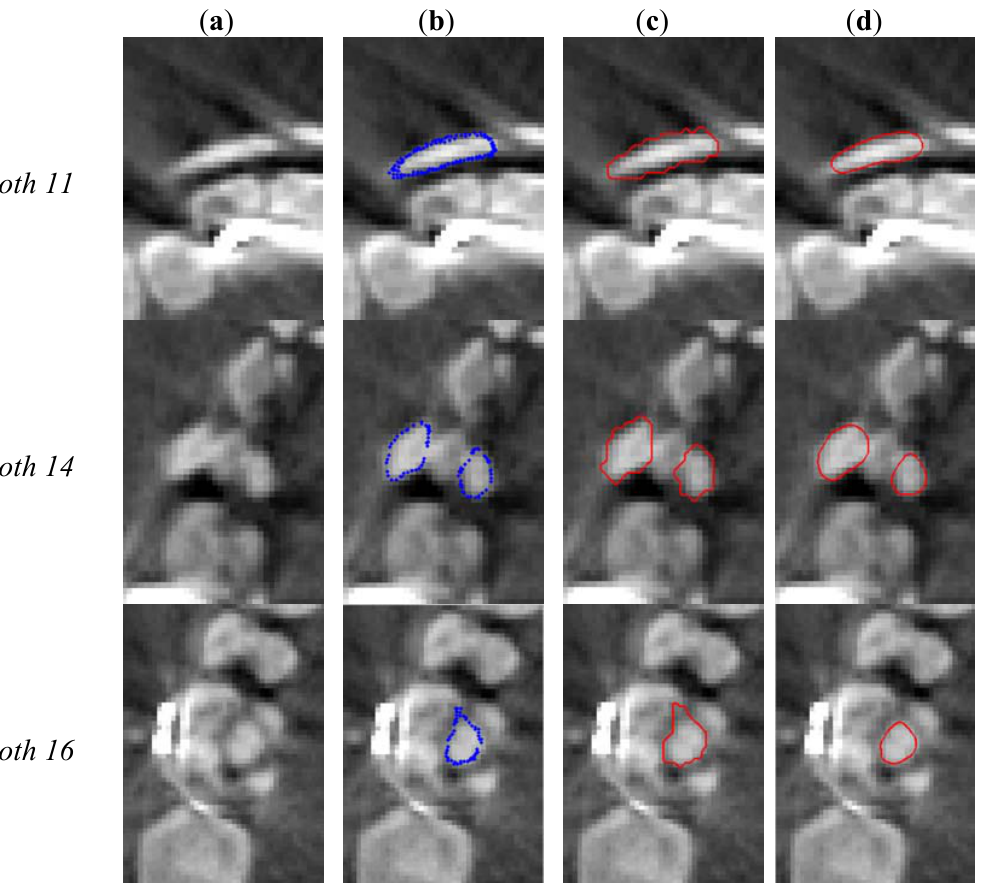
Figure 10. Contour extractions of three teeth by processing the first slices: ( a ) original images; ( b ) contouring initializations; ( c ) initial definitions of contours for the level set method; ( d ) results of the DRLSE method.